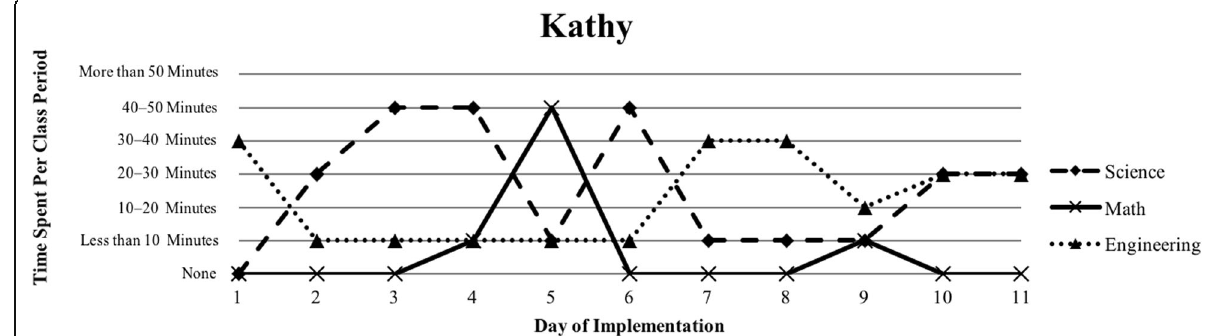
Fig. 6 Kathy ’ s implementation of the Heat Transfer 1 in her 6th grade science class